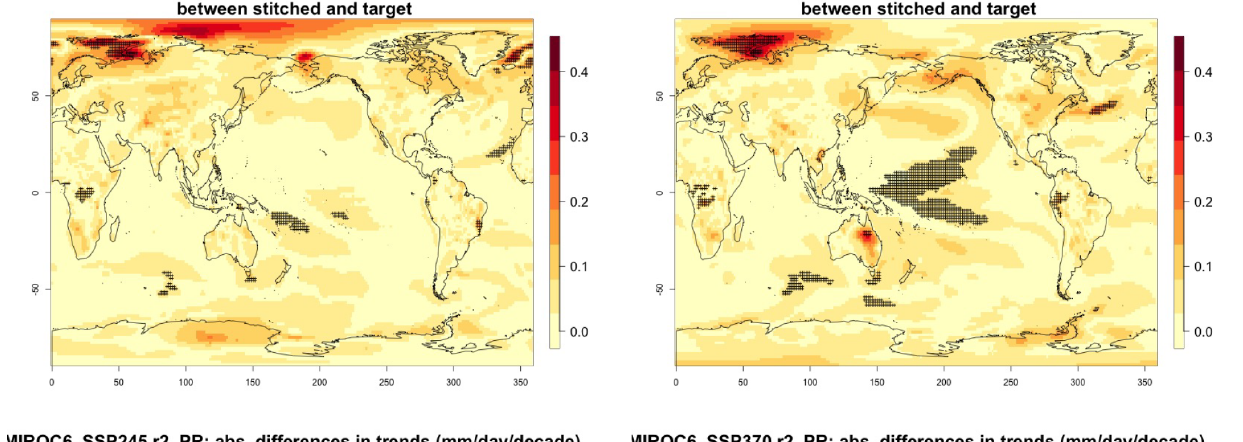
https://doi.org/10.5194/esd-13-1557-2022 Earth Syst. Dynam., 13, 1557–1609,